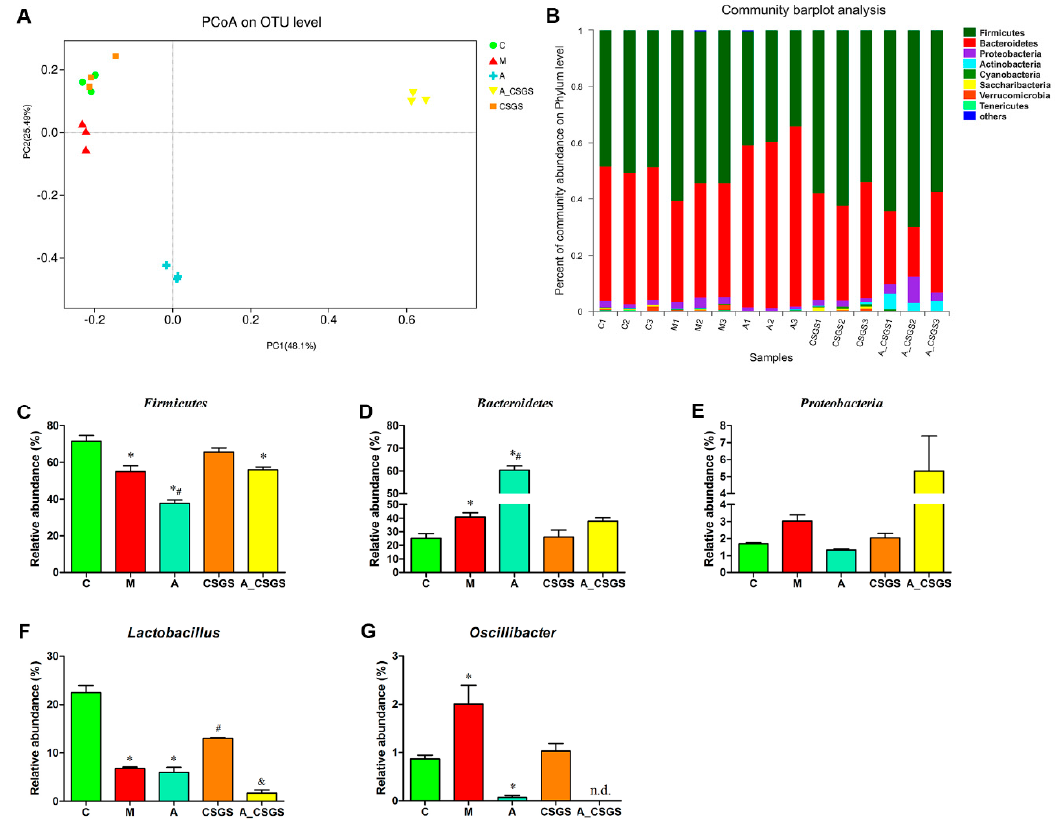
Figure 3. Principal coordinate analysis (PCoA) scatter plot of operational taxonomic units (OTUs) ( A ) and relative gut microbiota abundance at the phylum ( B – E ) and genus level ( F – G ) in di ff erent treatment groups of rats. C: control group; M: CVS model group; A: Antibiotic treated group with CVS; CSGS: CSGS treated group; A_CSGS: Antibiotic + CSGS treated group. * p < 0.05 vs. C; # p < 0.05 vs. M; & p < 0.05 vs. CSGS. n.d. indicates not detected. The post hoc ANOVA used for statistical analysis and data with different superscript letters are significantly different.